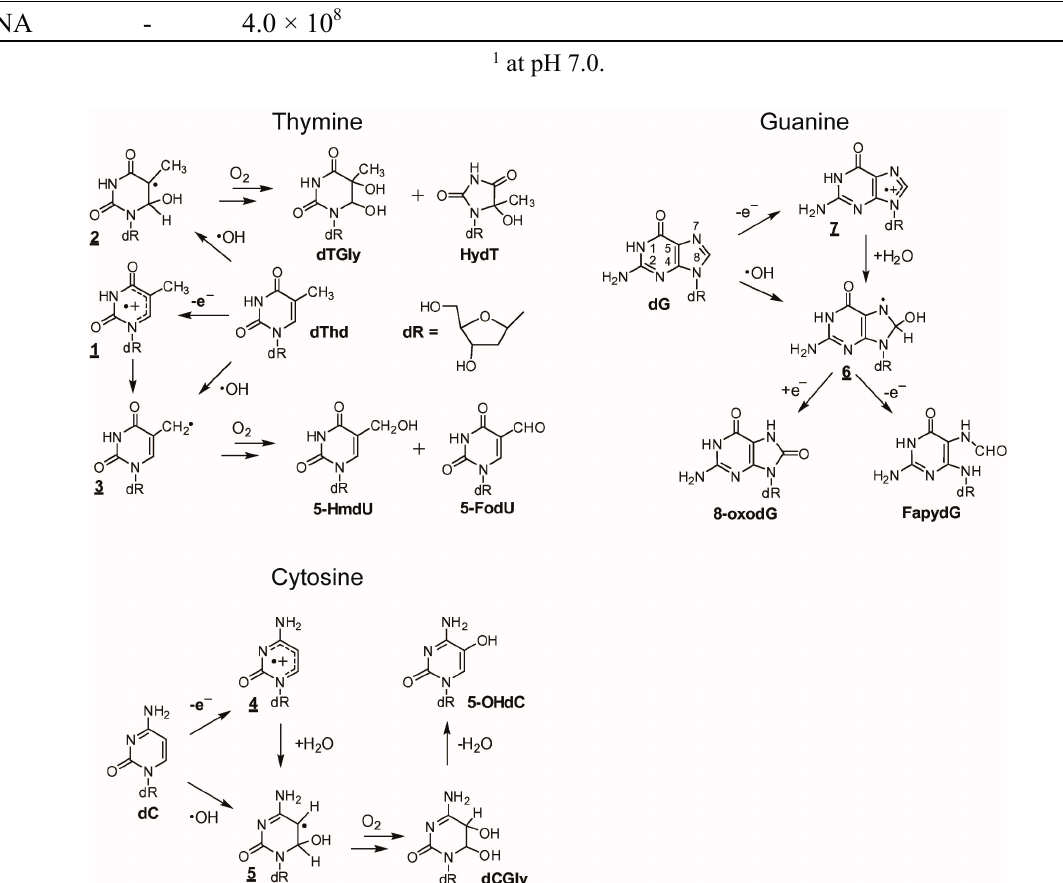
Figure 2. One-electron oxidation and ● OH-mediated oxidation of thymine, guanine and cytosine. Reproduced from [117] with the permission of Elsevier, Inc.,